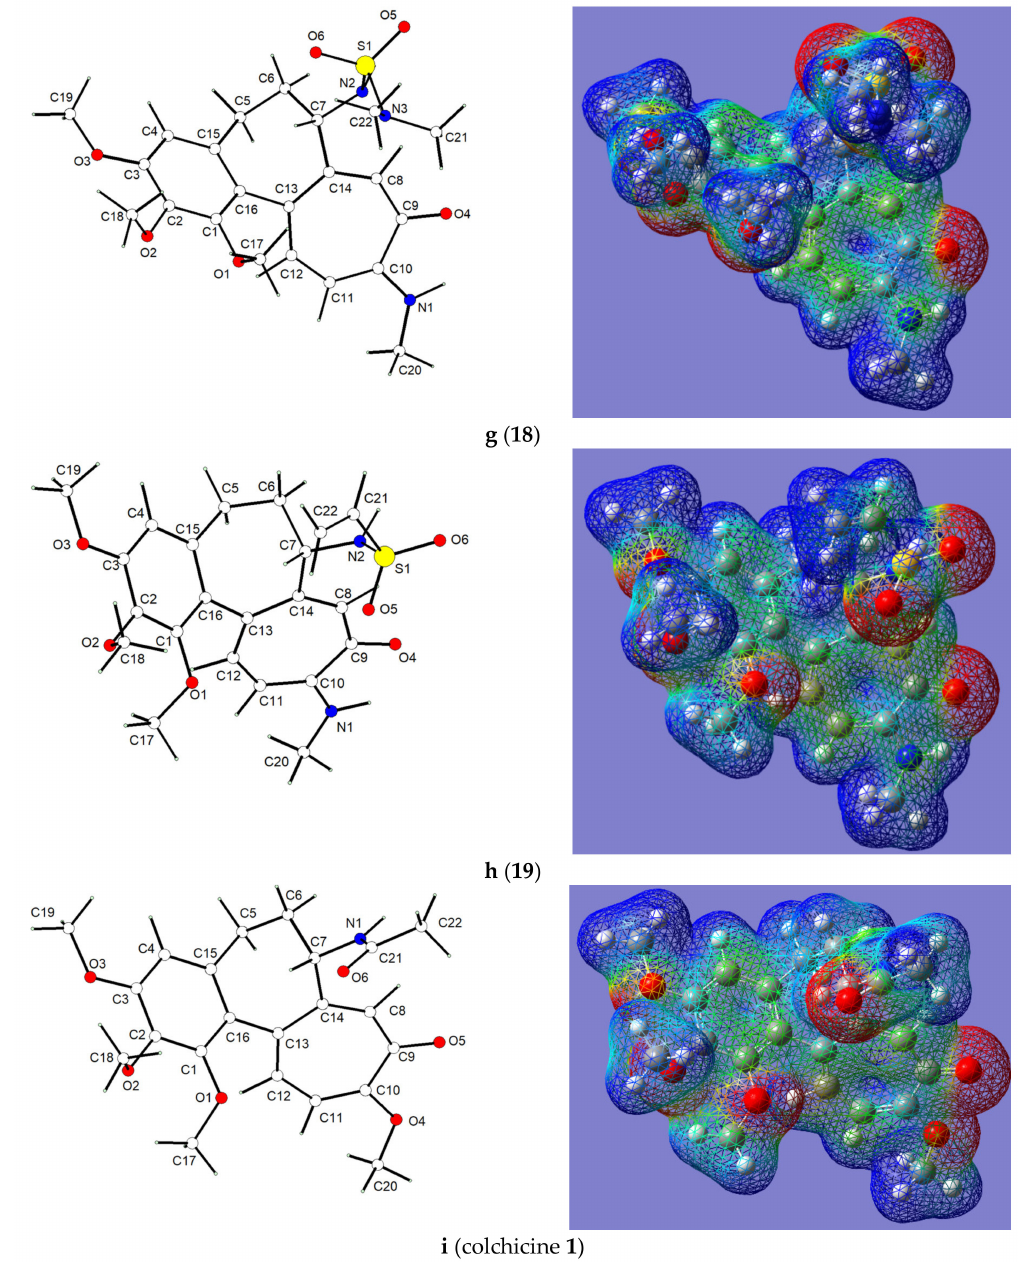
Figure 2. Optimized conformation (left) and three-dimensional molecular electrostatic potential map (right) for colchicine derivatives ( a – h ) and colchicine itself ( i ), for comparison. Color code: − 0.05 eÅ − 1 (red) to + 0.05 eÅ − 1